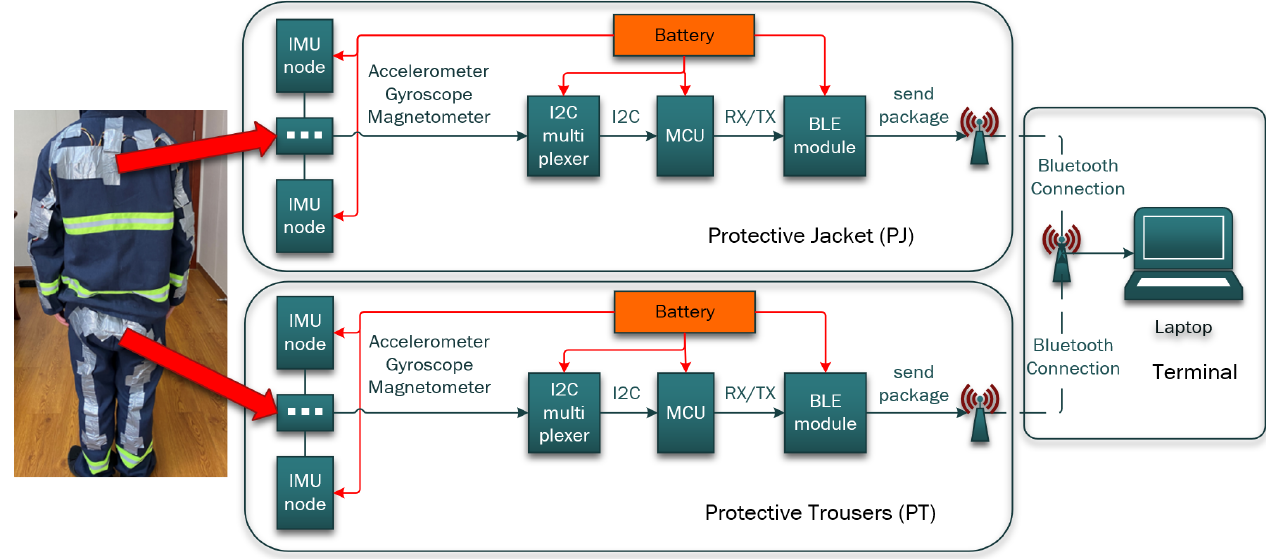
Figure 6. Overall design of the communication framework from the PJ and PT to a terminal via BLE 4.2 wireless